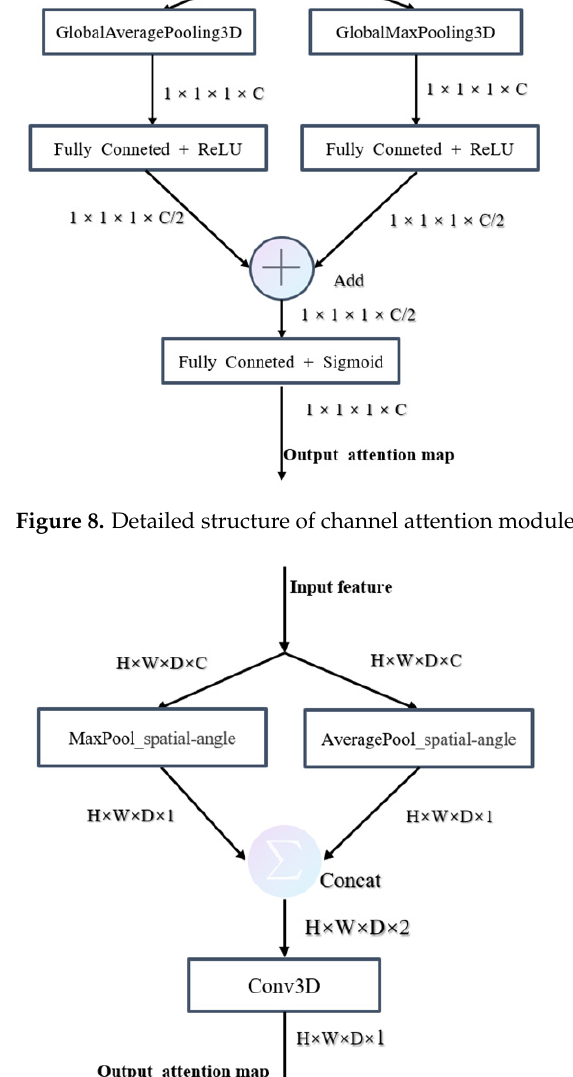
Figure 9. Detailed structure of spatial-angle attention module.